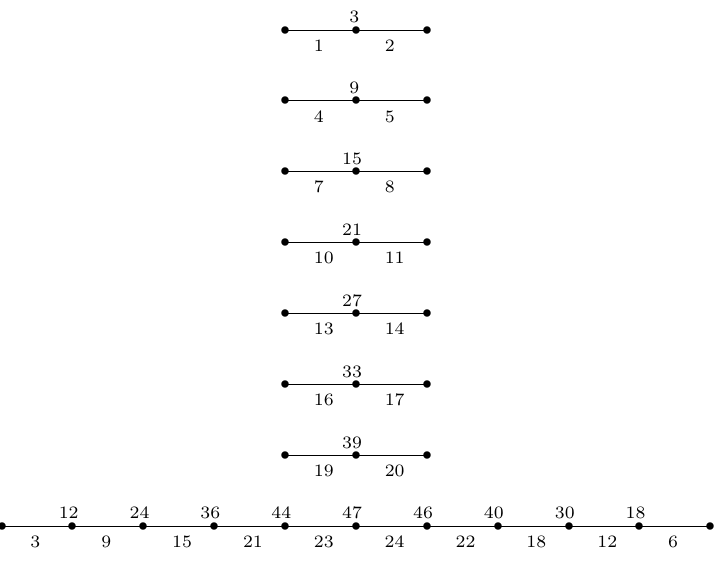
Figure 2. Edge labels and vertex sums of 7 P